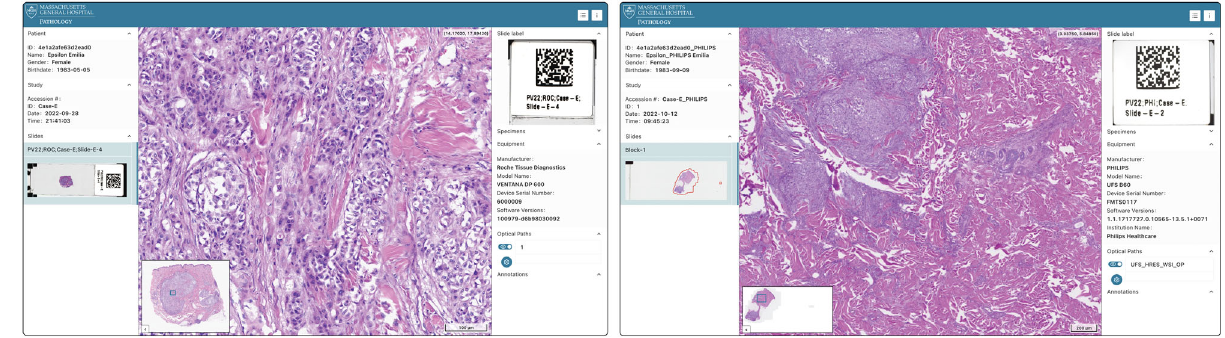
Fig. 9 | Successful demonstration of interoperability with DICOM con- formant scanners and archives from different manufacturers at a DICOM Connectathon. ScreenshotsoftheSlimuserinterfacedisplayingslidemicroscopy images that were acquired and stored by commercially available devices during a